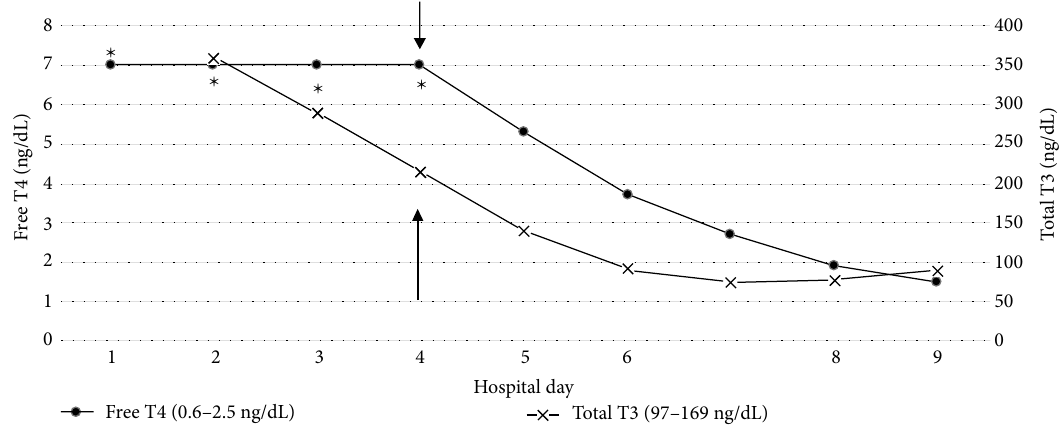
Figure 1: Free T4 and total T3 Levels during hospitalization. ∗ Values were >7 ng/dL, → first day of